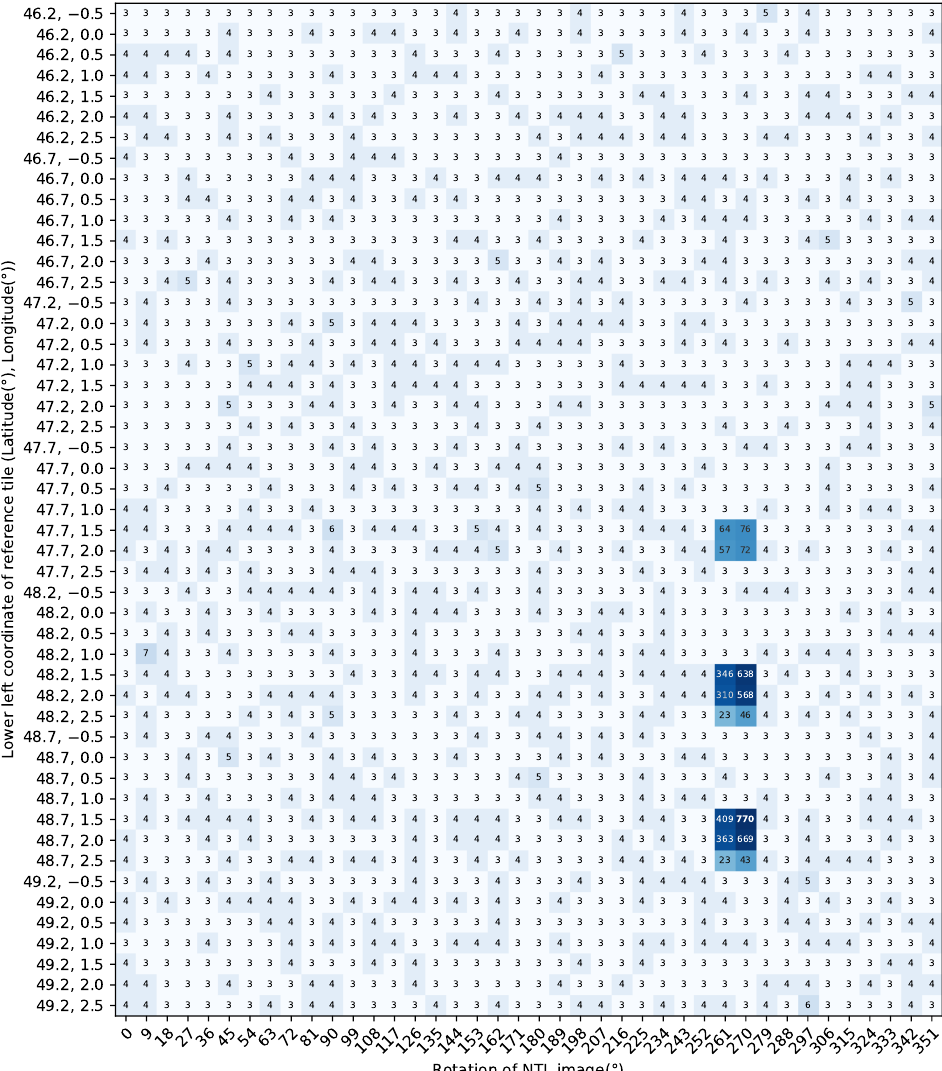
Figure 6. Number of filtered matches for each combination of reference tile and rotation for Paris. The maximum number of matches (770) was found for the reference tile with the lower left coordinates at 48.7 ◦ Latitude and 1.5 ◦ Longitude and a rotation difference of 270 ◦